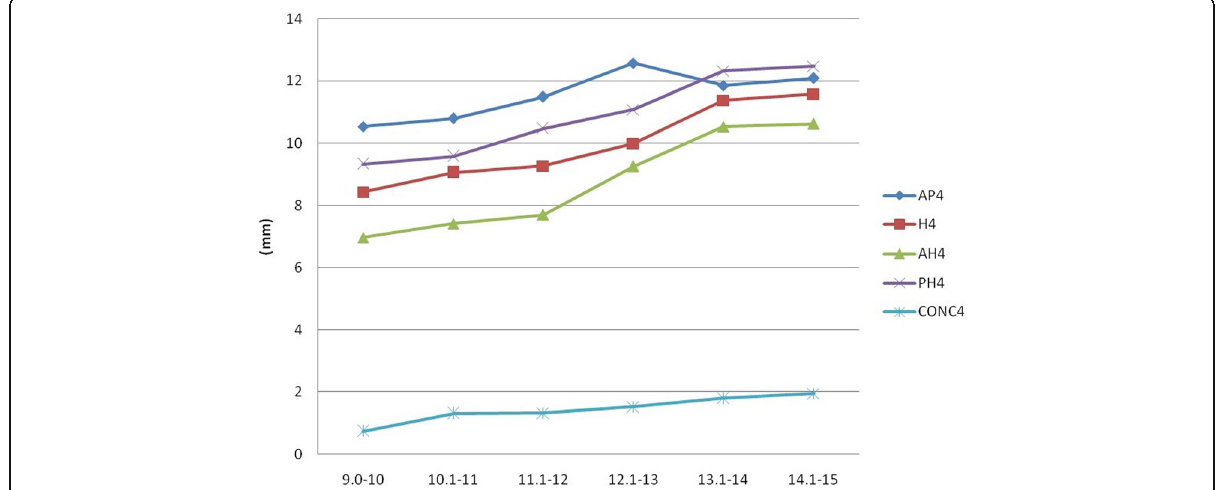
Fig. 3 Changes in the parameters of C4 in females (AH, anterior height, PH, posterior height; H, middle height; AP, anteroposterior length; CONC, depth of